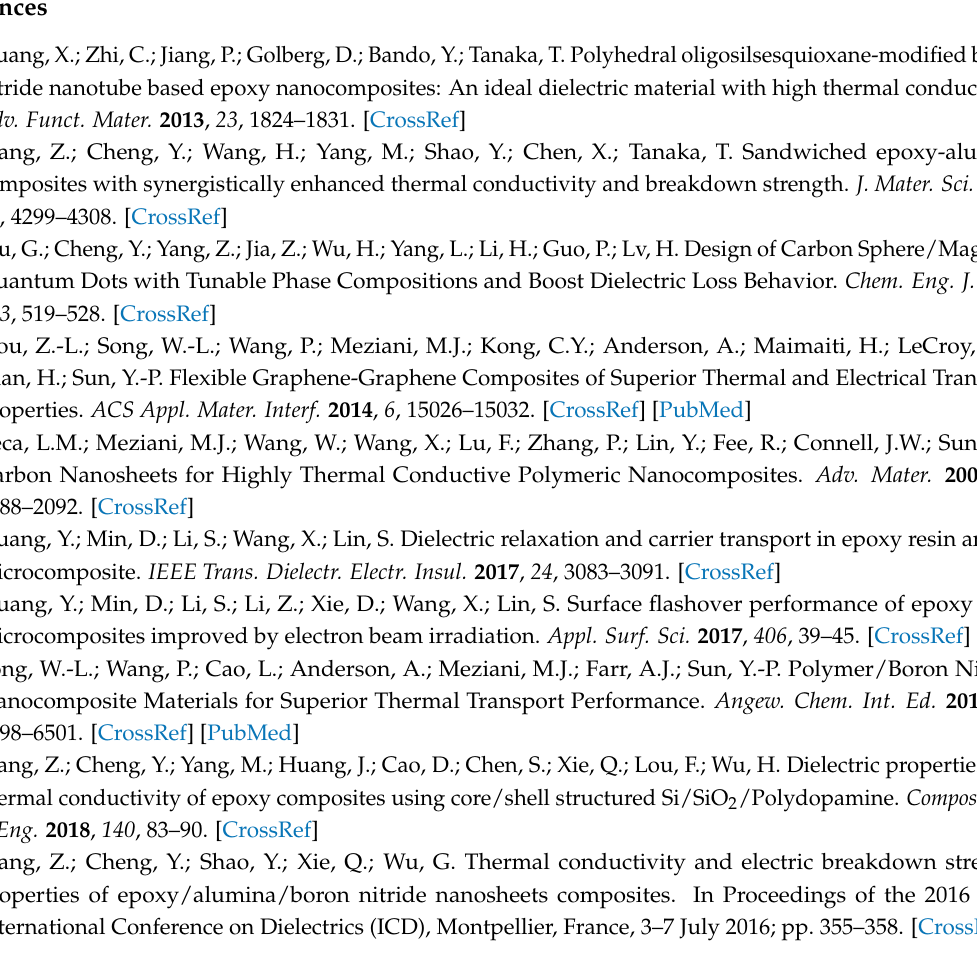
Figure S1: The Proportion of PVB/B 2 O 3 is 700 mg/350 mg, the voltage is 16.14 kV, the flow is (a) 0.75 mL/h (b) 1.5 mL/h (c) 2.0 mL/h (d) 2.5 mL/h (e) 4.0 mL/h (f) 1.0 mL/h. Figure S2: DSC curves of the BNNF/epoxy composites with different filler content under nitrogen atmosphere. Figure S3: TGA curves of the BNNF/epoxy composites with different filler content under nitrogen atmosphere. Table S1: A summary of the detailed data information on thermal